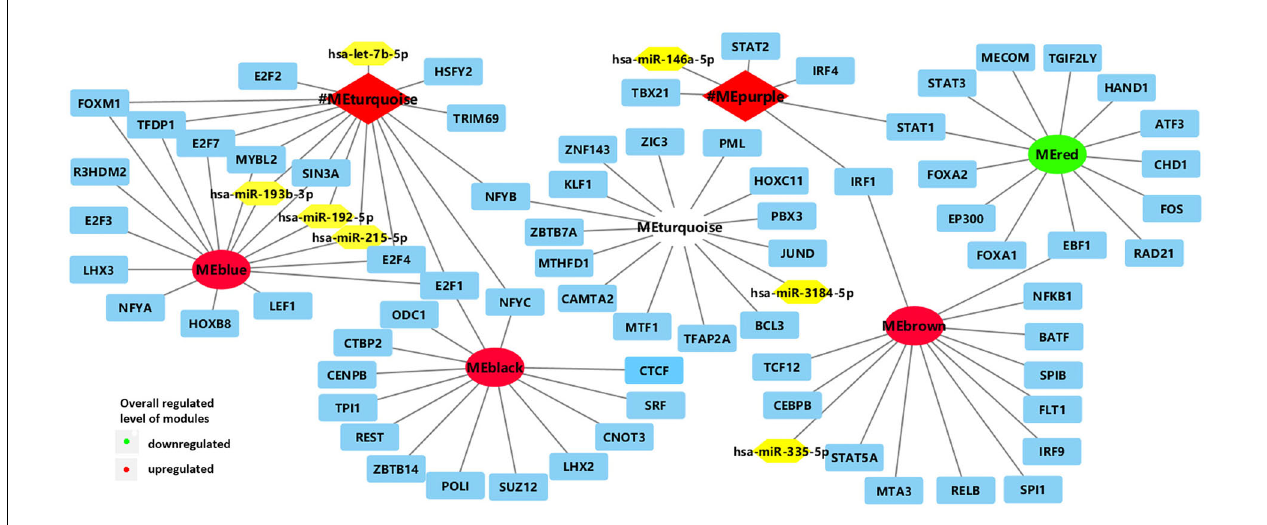
FIGURE 2 | Network of enriched TFs (blue) and regulatory non-coding RNAs (yellow) with clinically significant modules (turquoise and purple modules in BRCA1 -MUT BC; red, blue, turquoise, black, and brown modules in BRCA2 -MUT). #ME represents modules from BRCA1 -MUT samples. Red represents upregulated modules; green represents downregulated